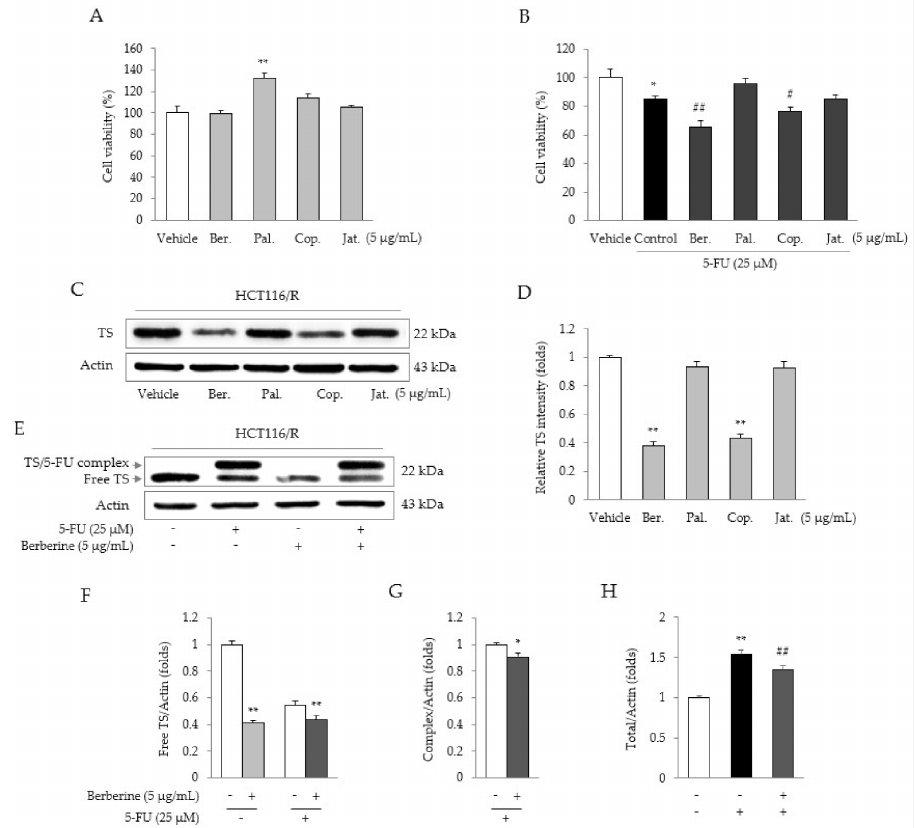
Figure 5. Investigation to identify the active compound of CRE. Cell viability was measured by treatment with the four main compounds of CRE ( A ) and evaluation of their synergistic effects with 5-FU in HCT116/R cells ( B ). TS protein expression levels ( C ) and their quantification ( D ) were determined in HCT116/R cells. The effects of berberine on TS protein expression were determined with/without 5-FU treatment ( E ), and the intensities of free ( F ), complexed ( G ), and total TS ( H ) were quantified. Data are expressed as the mean ± SD ( n = 3) values. * p < 0.05 and ** p < 0.01 compared with vehicle-treated cells. # p < 0.05 and ## p < 0.01 compared with 5-FU-treated cells. Ber; berberine, Pal; palmatine, Cop; coptisine, Jat;